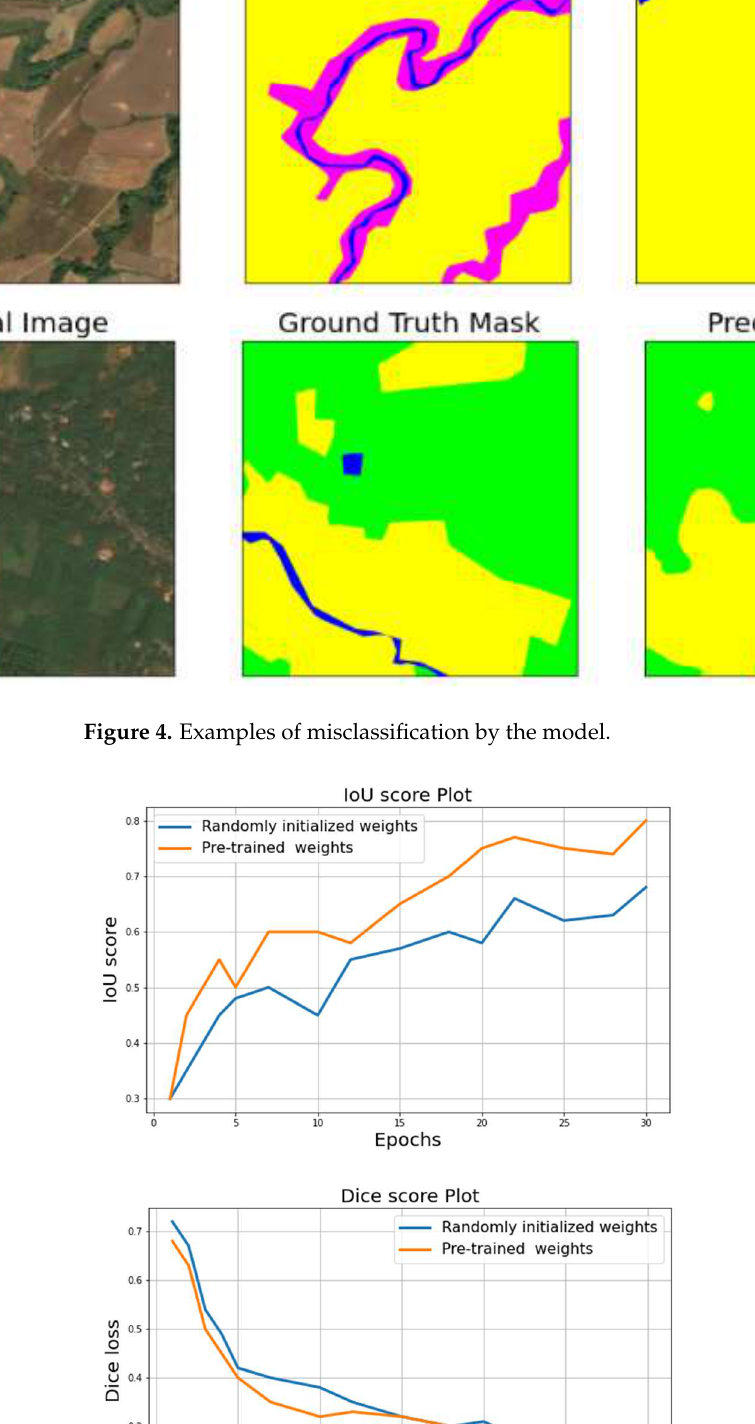
Figure 5. Learning curves of trained model at the training and validation stages.